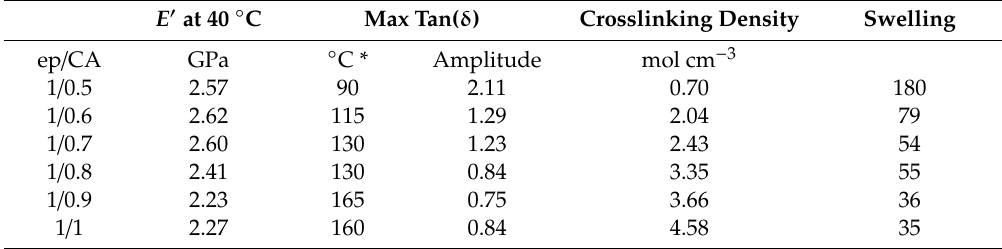
Table 3. Mechanical properties of epoxy thermosets depending on the ep / CA